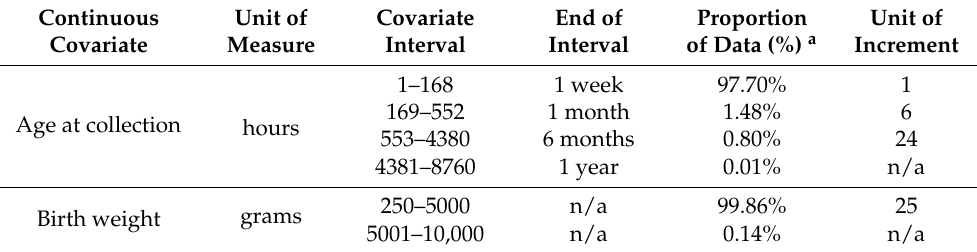
Table 3. Selection of unit increment by data density for the establishment of moving